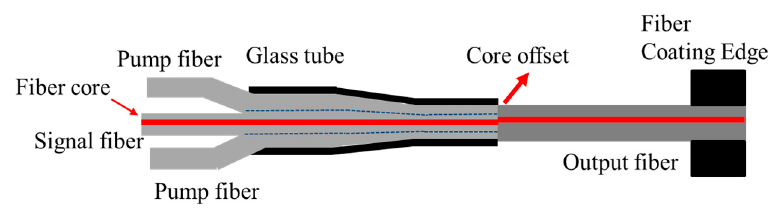
Figure 1. The brief diagram of the pump-signal